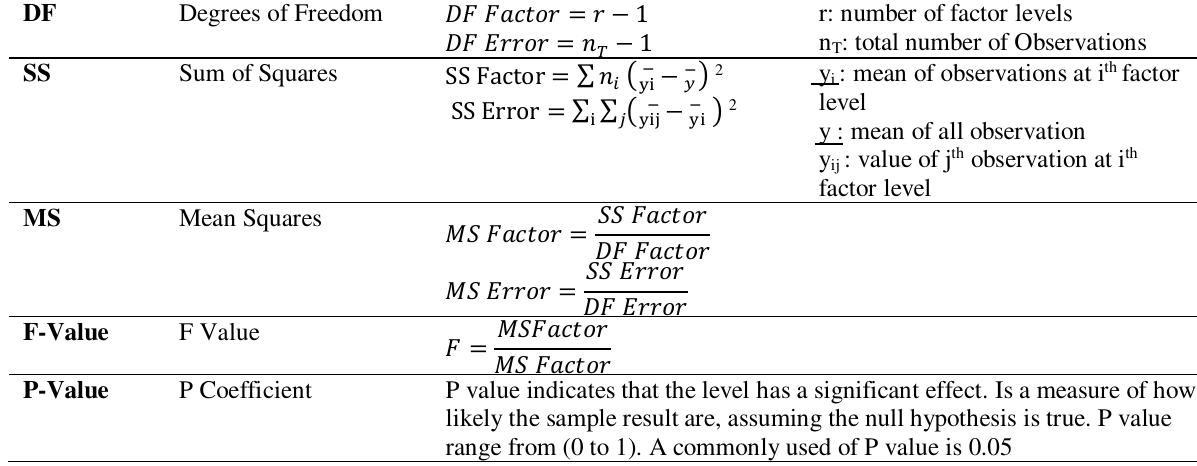
formulas used to conduct the ANOVA analysis.